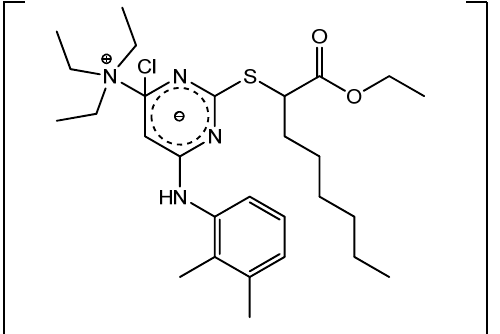
Figure 5. Chemical structure of the Meisenheimer complex intermediate 10